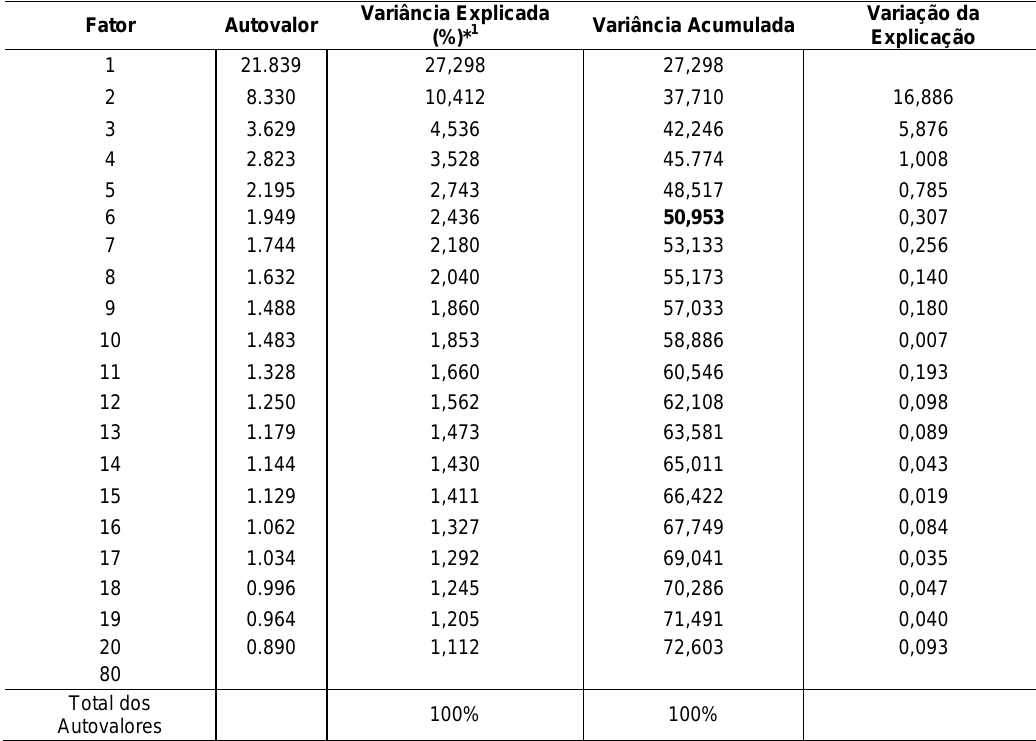
Tabela 2. Autovalores RESTQ-Coach Versão